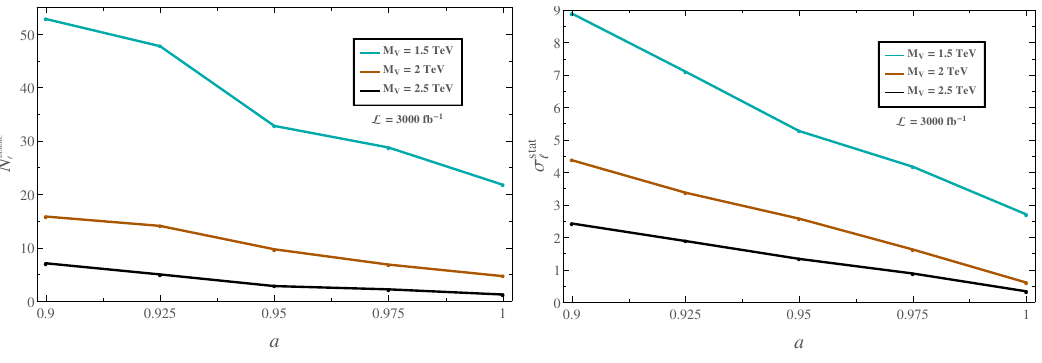
Figure 17 . Predictions for the number of pp the statistical signi(cid:12)cance, (cid:27) stat Marked points correspond to our selected benchmark points in (cid:12)gure 4. The cuts in eq. (5.5) have been